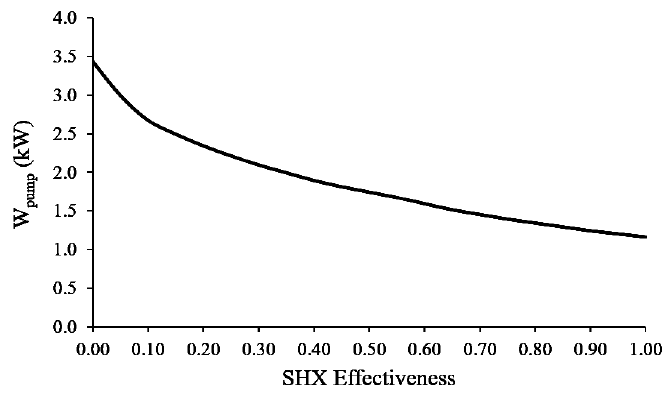
Figure 34. Effect of ε SHX on pumping power.